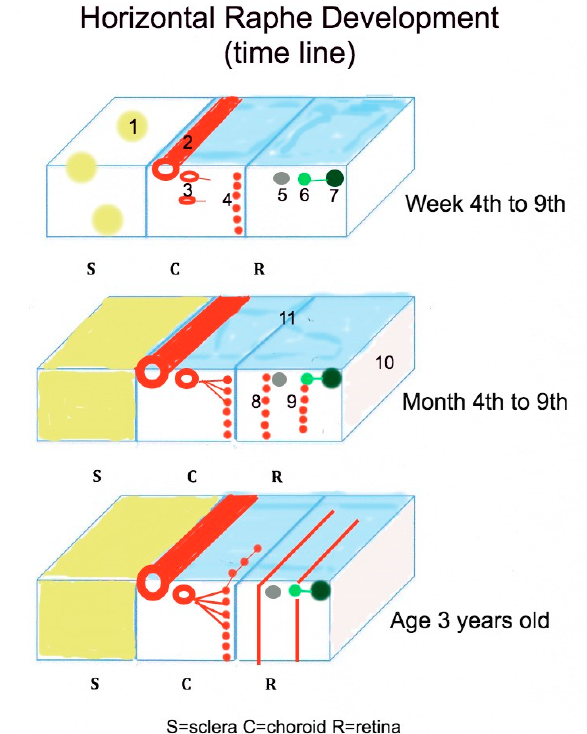
Figure 6. Schematic summary of the structures influencing the development of the horizontal raphe. 1 = scleral condensation, 2 = long posterior ciliary artery appearance, 3 = short posterior ciliary artery, 4 = immature choriocapillaris, 5 = Müller cells, 6 = retinal ganglion cells, 7 = retinal nerve fiber layer, 8 = immature deep retinal capillary bed, 9 = immature superficial retinal capillary bed, 10 = inner limiting membrane, 11 = chorio-retinal interface.